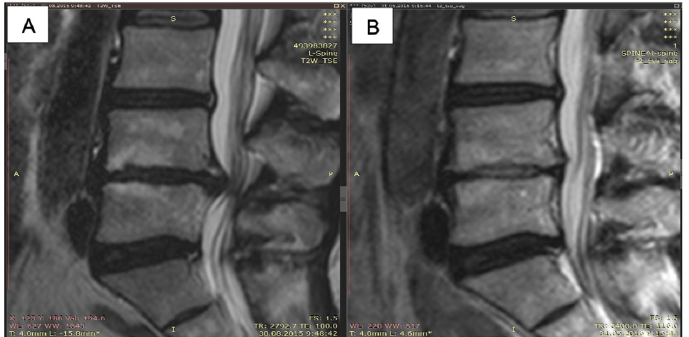
Figure 11. Combination of LRD and transforaminal endoscopic discectomy for a female, 51 y.o., L4L5 disc herniation, MRI T2 WI: ( A ) Preoperative—disc degeneration: Pfirrmann Grade 4; ( B ) post- operative—disc degeneration Pfirrmann Grade 2. DDD decreased and formation of the new